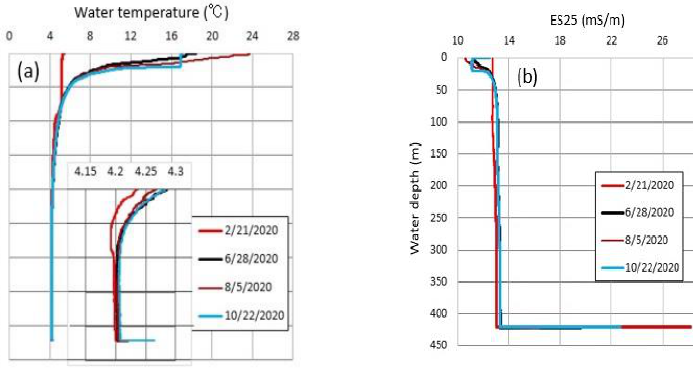
Figure 5. Vertical profiles of ( a ) water temperature, ( b ) EC25 and ( c ) DO on the four days in 2020. In ( a ), the temperature at 200 m or more in depth is enlarged. The DO profiles are shown in both satu- ration (%) and amount